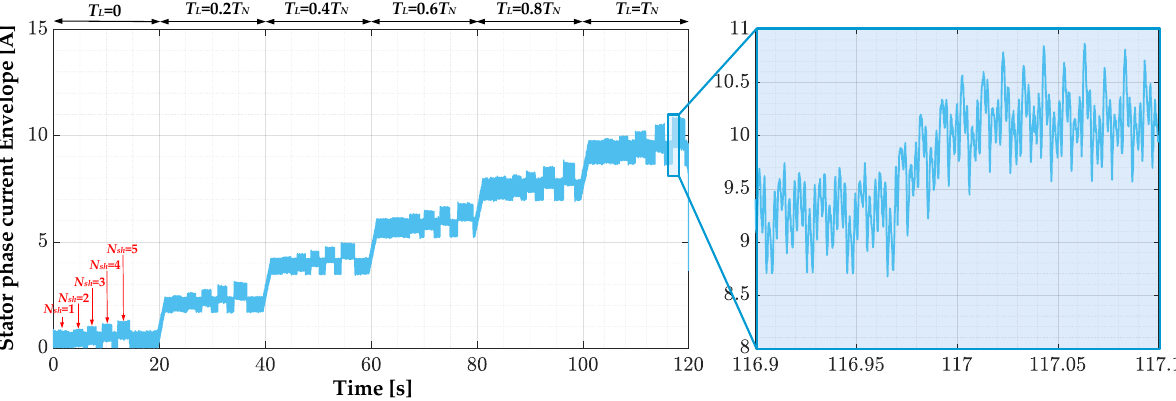
Figure 2. Effect of ITSCs in the PMSM stator winding on the waveform of the stator phase current envelope (phase A), experimental study ( T L = var, f s = f sN = 100 Hz). The effect of the ITSCs on the stator currents space vector module waveform is pre- sented in Figure 3. Both ITSCs and load torque affect it in a way similar to that seen for the stator phase current envelope. Therefore, to isolate only the symptoms of the stator winding fault, the diagnostic signals discussed above will be processed using CWT analysis.